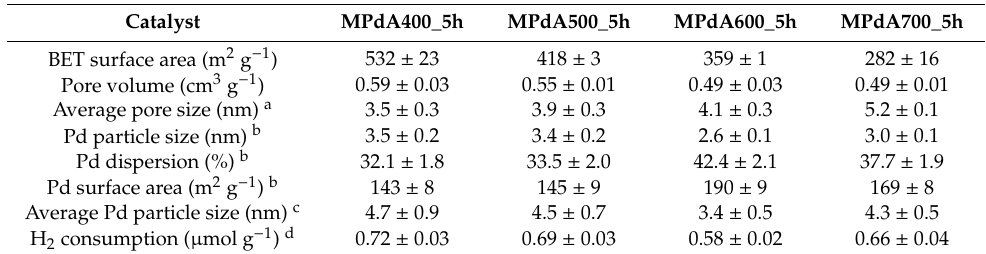
Table 1. Physicochemical properties of mesoporous Pd-Al 2 O 3 (MPdA) catalysts calcined at di ff erent temperatures for 5